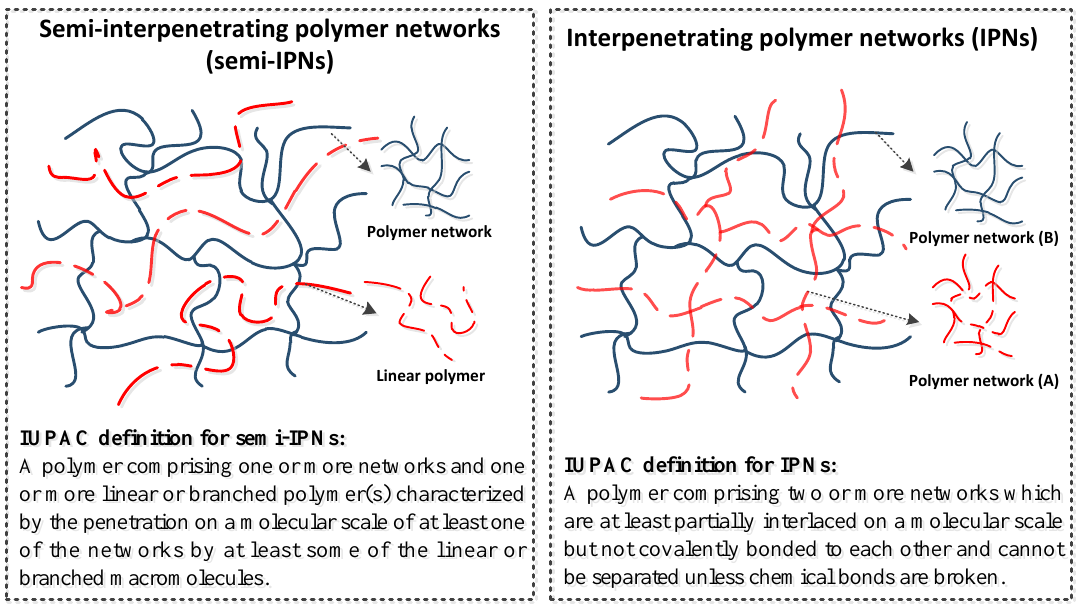
Figure 10. Schematic representation of semi- interpenetrating polymer networks (IPNs) and